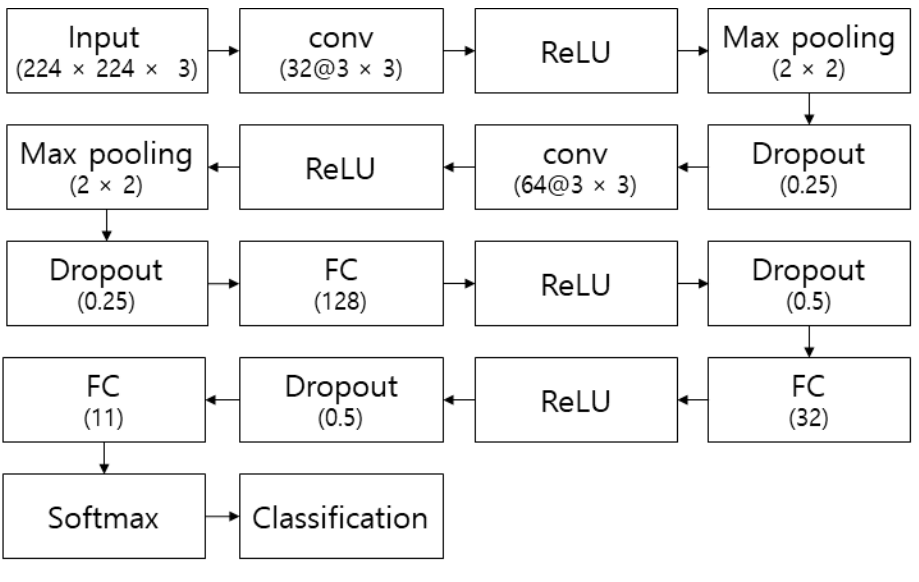
Figure 16. Structure of the simple CNN. Table 3. Classification performance of the CNNs without data augmentation under transfer learning (11 classes).